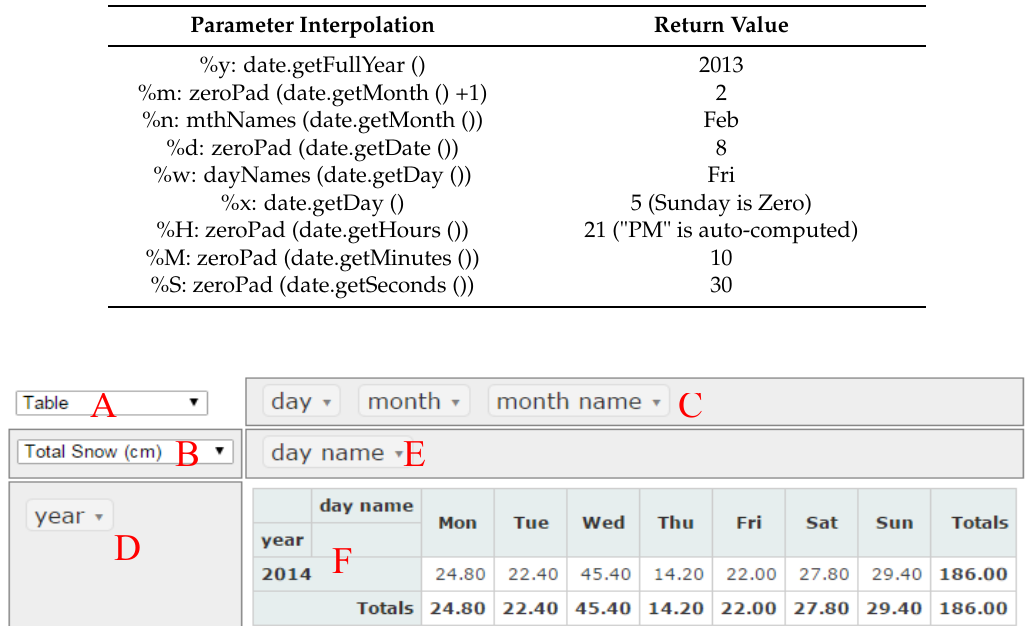
Table A1. Formatting parameters and corresponding return values.